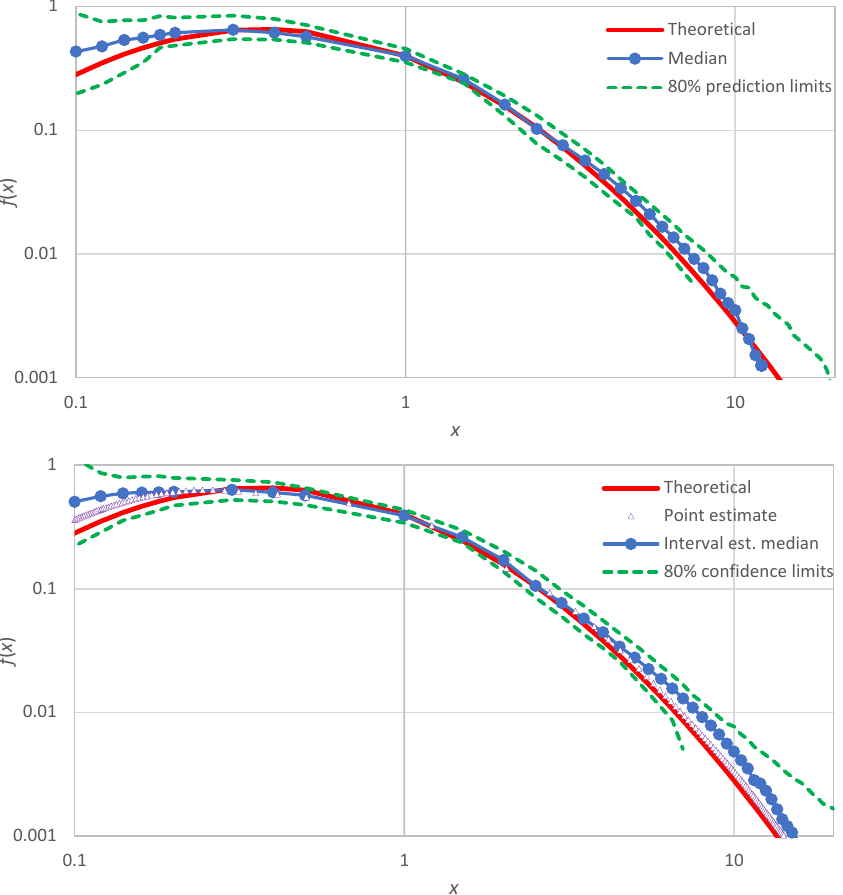
Figure 7. Comparison of the Monte Carlo simulation results for prediction limits of the lognormal distribution (with parameters as in Table 4) with the minimal version of the method ( upper ; copy of the middle panel of Figure 4) and for the confidence limits of the empirical probability density of Figure 1 ( lower ). The plotted “ point estimates ” are precisely those shown in Figure 1.